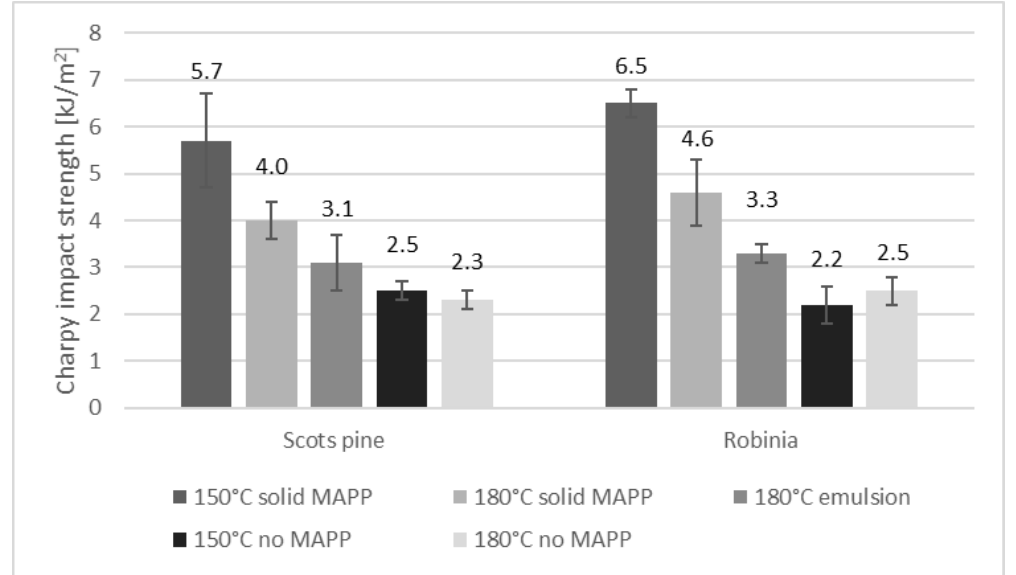
Figure 5. Charpy impact strength of composites with TMP based on Scots pine or Robinia. For comparison, values for composites with wood flour (softwood) were 6.9 N/mm 2 including MAPP (solid) and 2.8 N/mm 2 excluding MAPP.